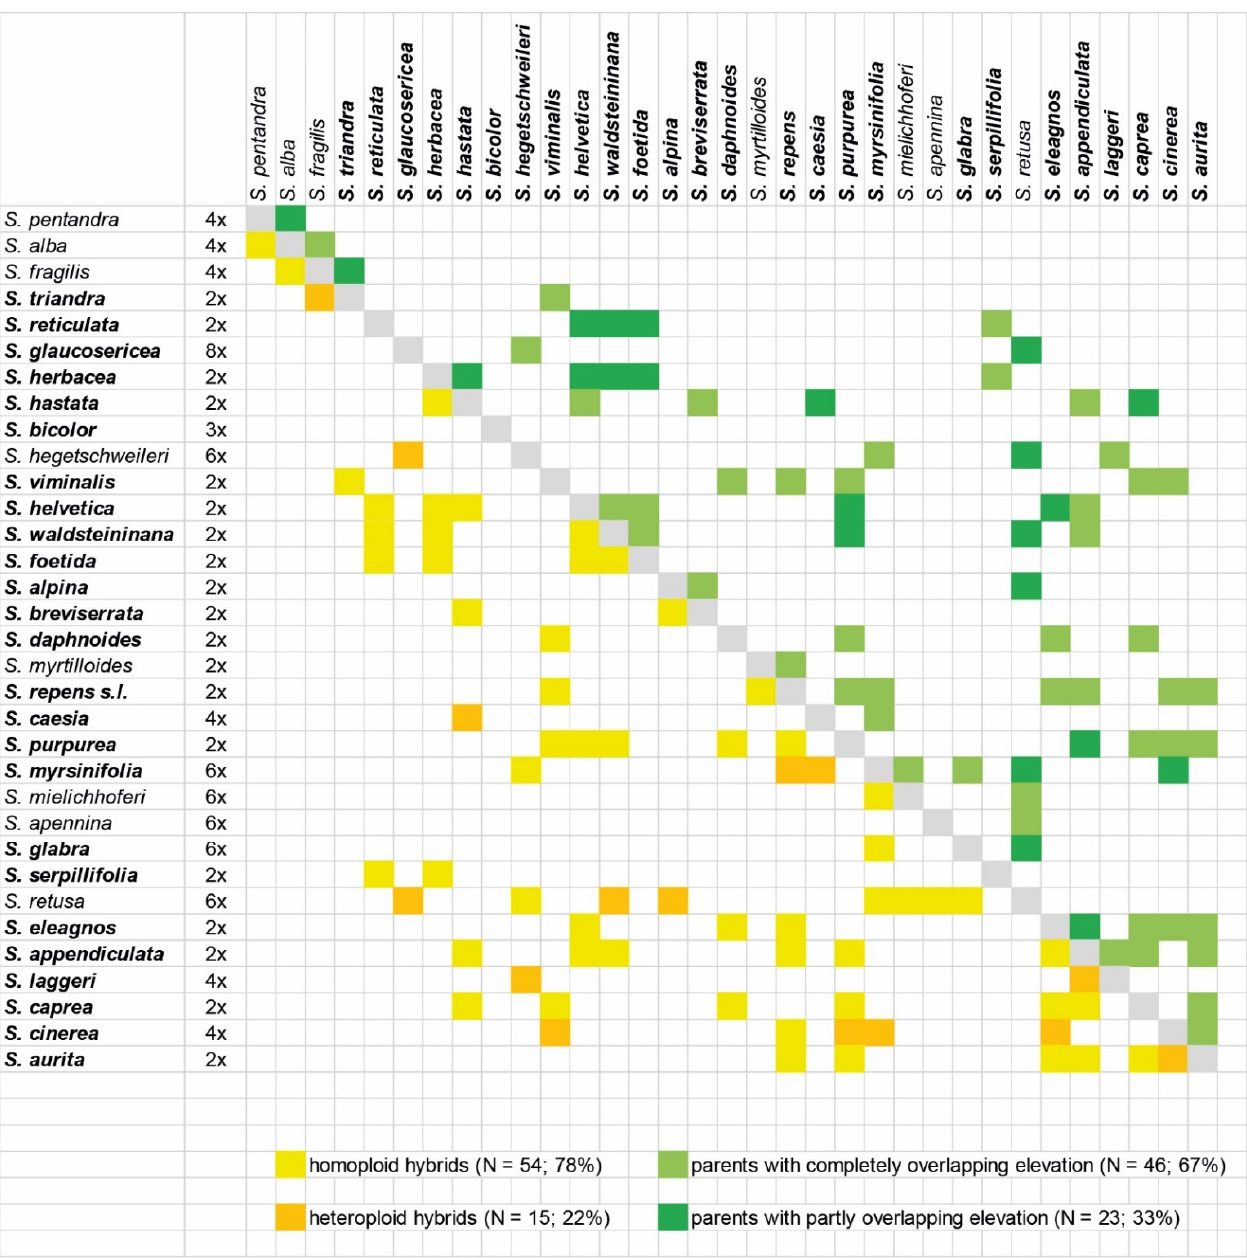
Figure 3. Crossing table of the extant 69 hybrid combinations between species in the Alps [2,4,11,15]. Doubtful crosses were excluded). The order of species follows phylogenetic relationships (see Figure 2), species included in the phylogeny are marked in bold face.